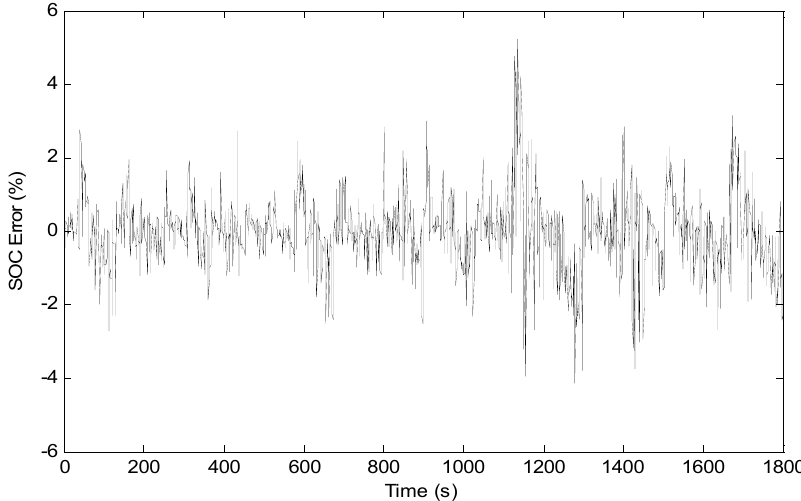
Figure 7. State of charge (SOC) estimated data values compared with actual data for PSO-ANN.